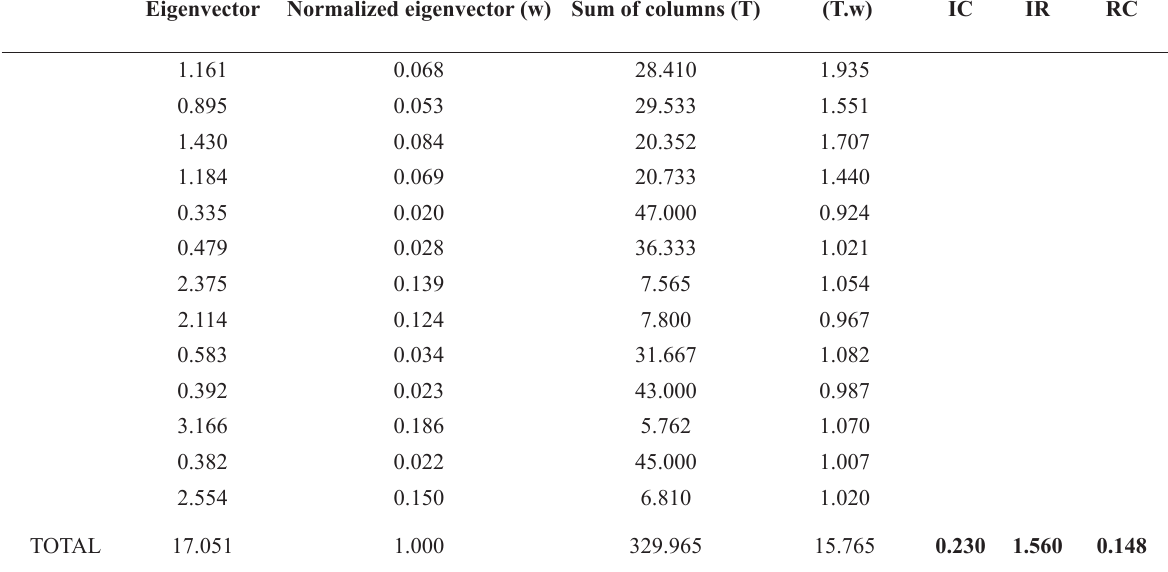
Inconsistency test.